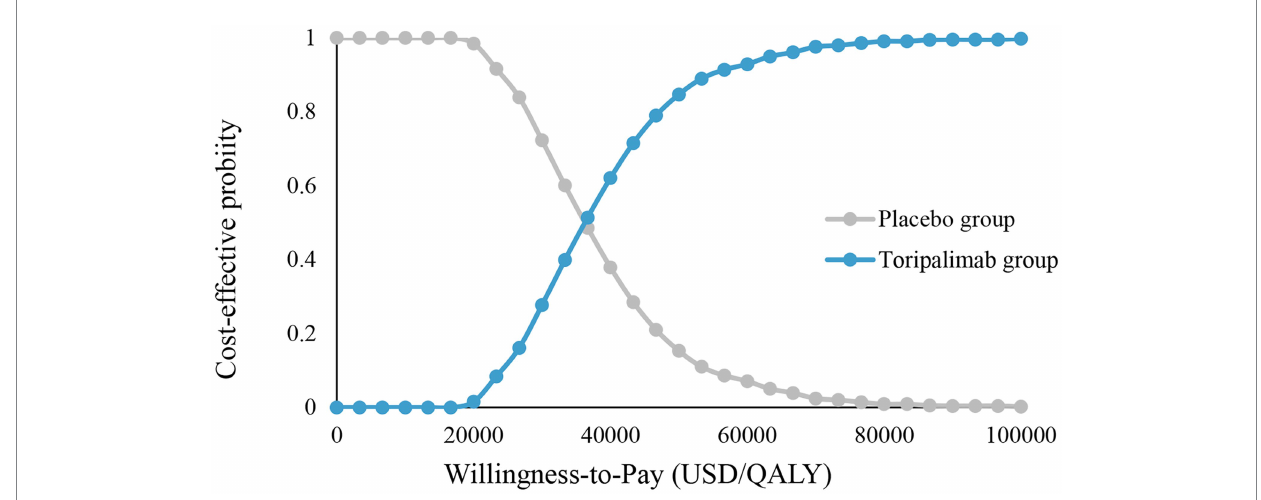
FIGURE 3 Cost-effectiveness acceptability curve. Placebo group, placebo + chemotherapy; toripalimab group, toripalimab + chemotherapy, QALY, quality-adjusted life